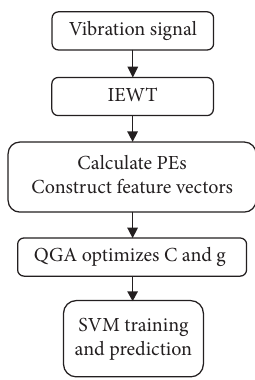
Figure 7: Fault diagnosis flow